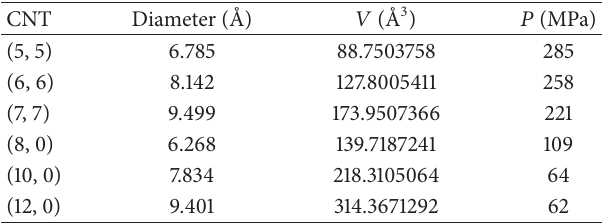
Table 4: The required pressure to complete RO